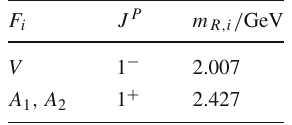
Table 4 Resonance masses of quantum number J P as indicated necessary for the parameterisation of D → ρ